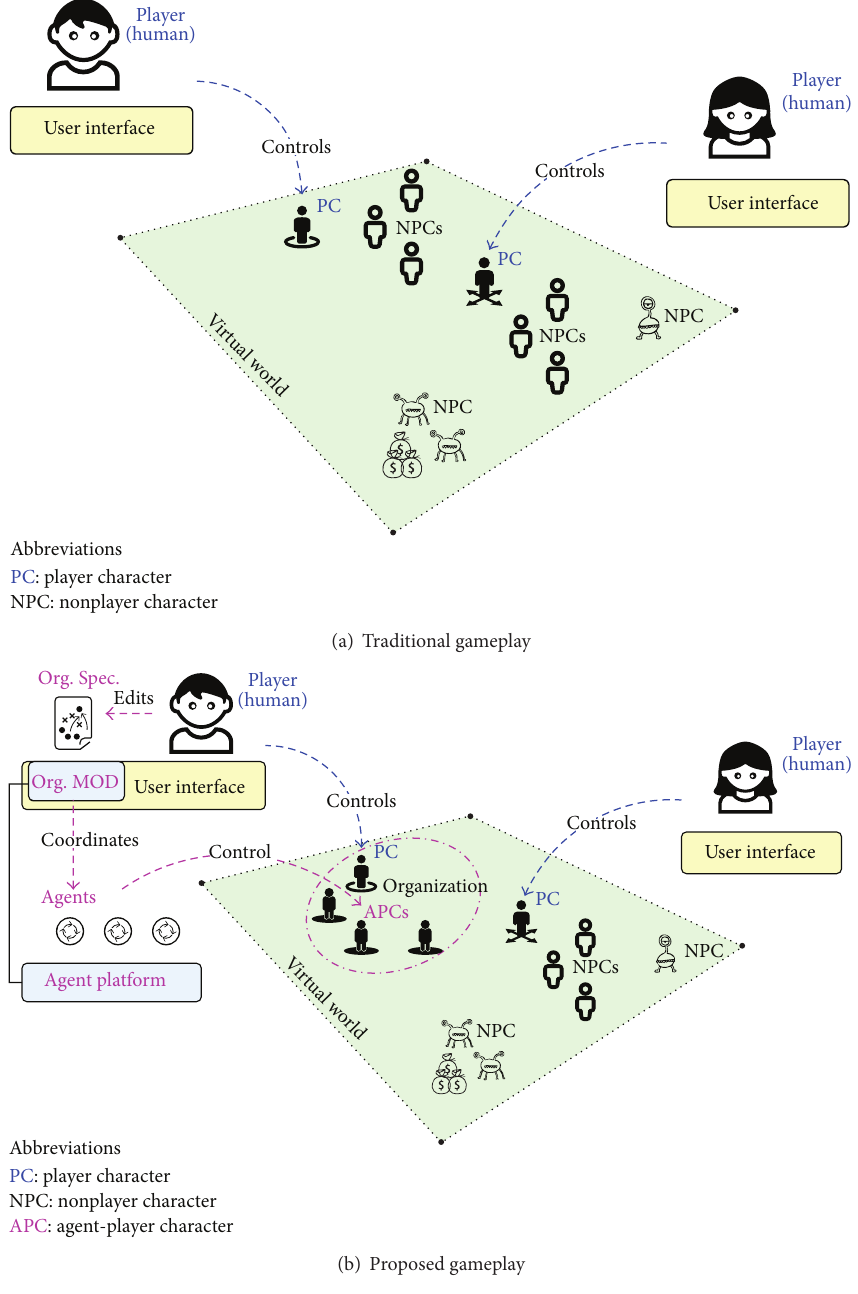
Figure 1: Organizational interface for computer